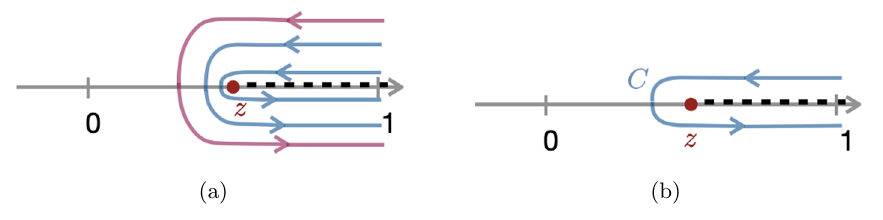
Figure 1 . Integration contour of the